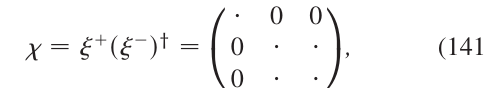
are underlined. Patterns and i